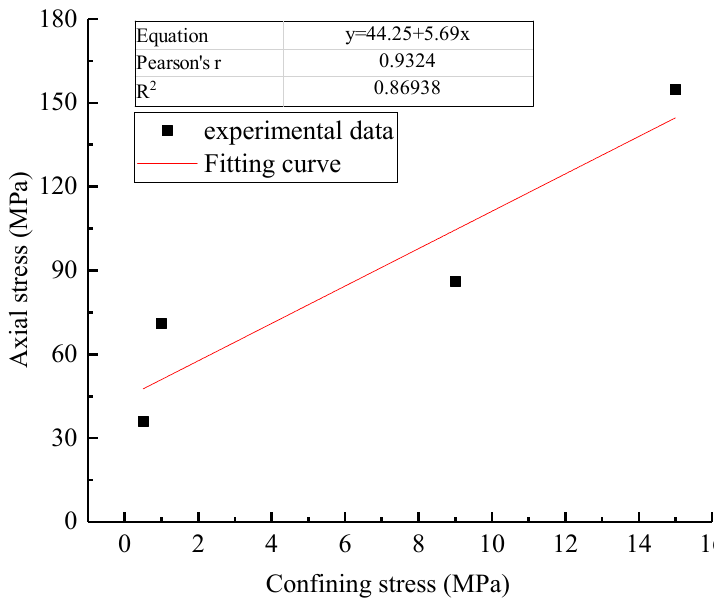
Figure 4. Relationship between confining pressure and peak axial pressure.